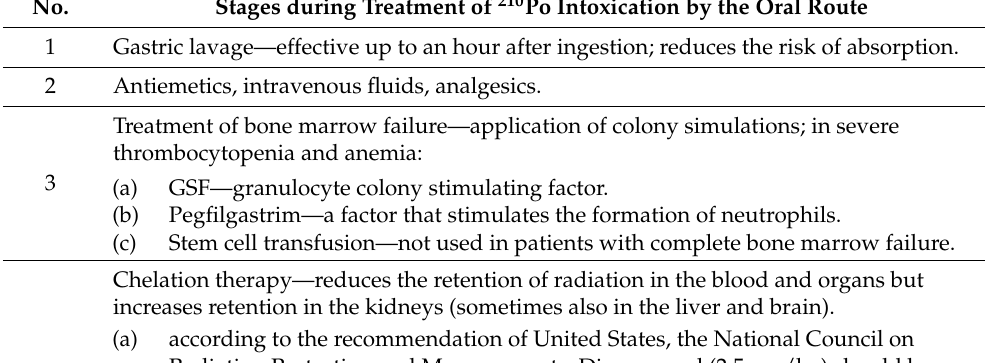
Table 4. Scheme of aid and treatment of poisoning with polonium-210 by the oral route